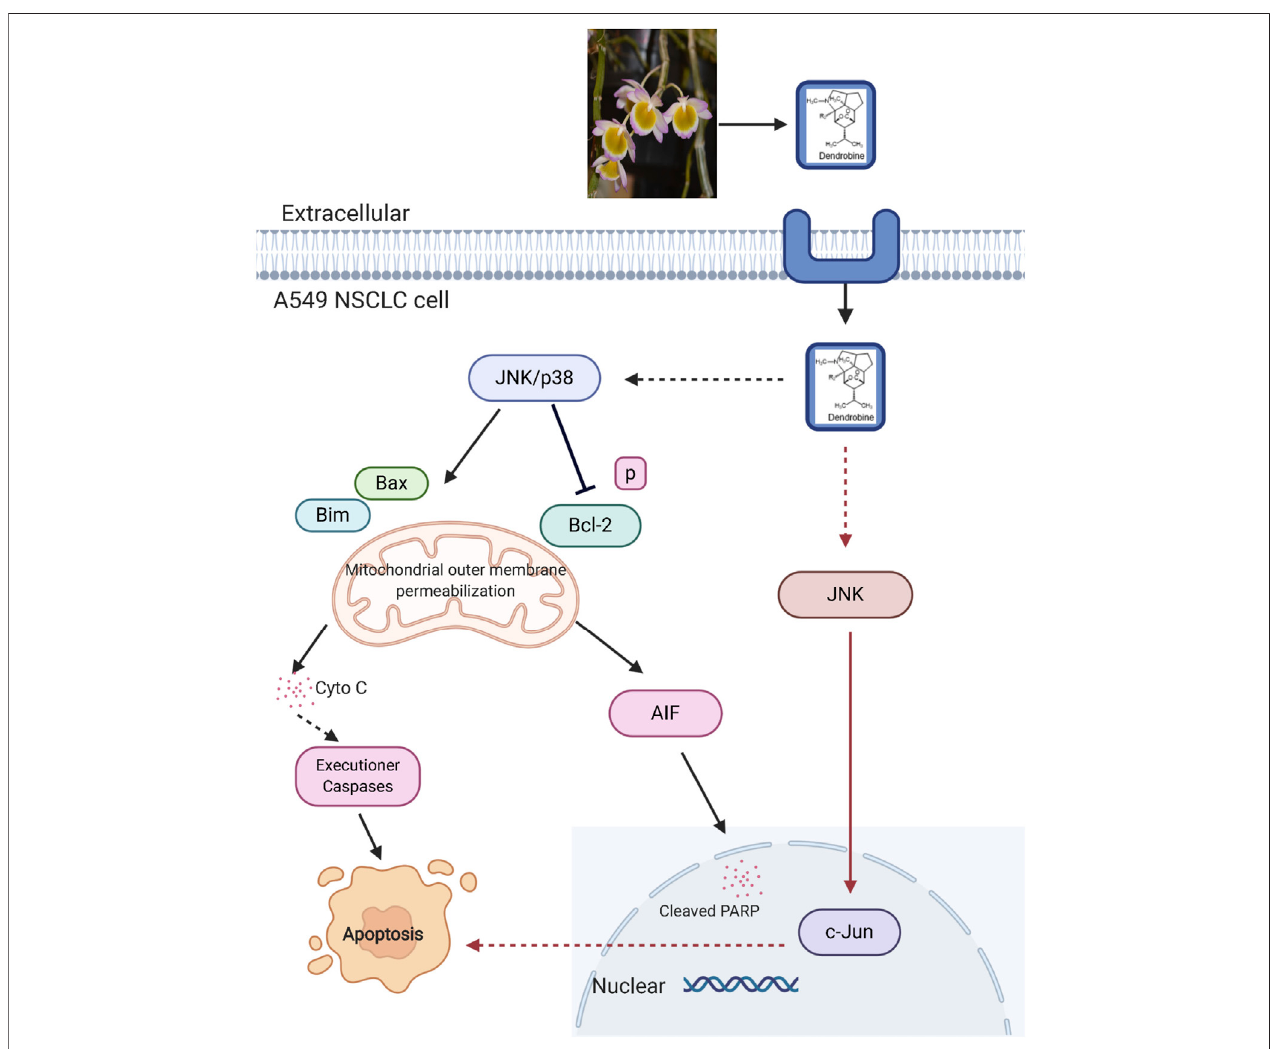
FIGURE6| Signaling pathway involvedindendrobineinducedapoptosis incancercells. JNK,c-JunN-terminalkinase;p38, p38 mitogenactivatedprotein kinase; Cyto C, cytochrome C; AIF, apoptosis inducing factor; Blc-2, B-cell lymphoma two; Bim, Bcl-2 interacting mediator of cell death; PARP, poly ADP-ribose polymerase.